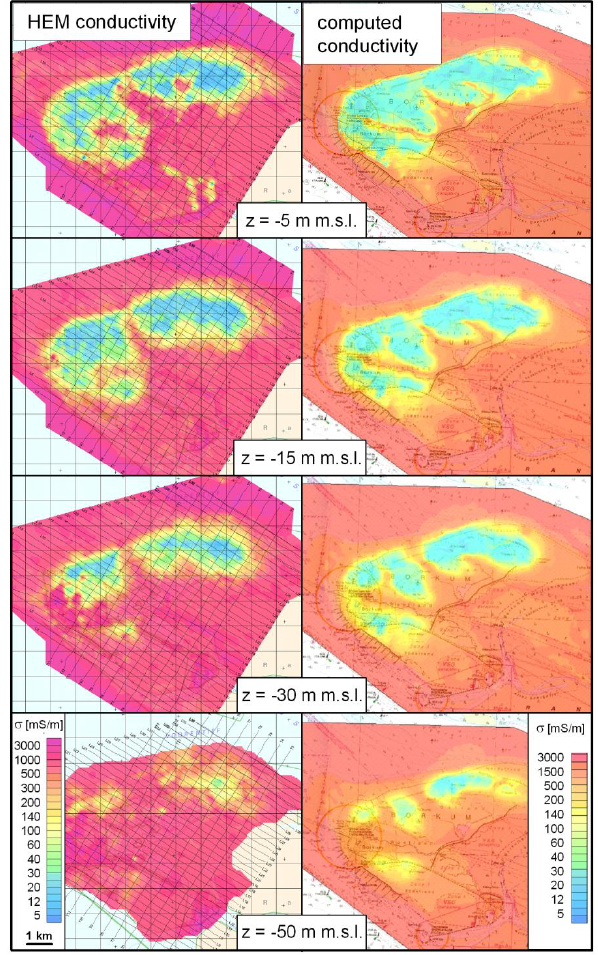
Fig. 13. Comparison between electrical conductivities derived from HEM data (left panel) and computed by the model (right panel) at different depths below sea level. Time of comparison is March 2008.